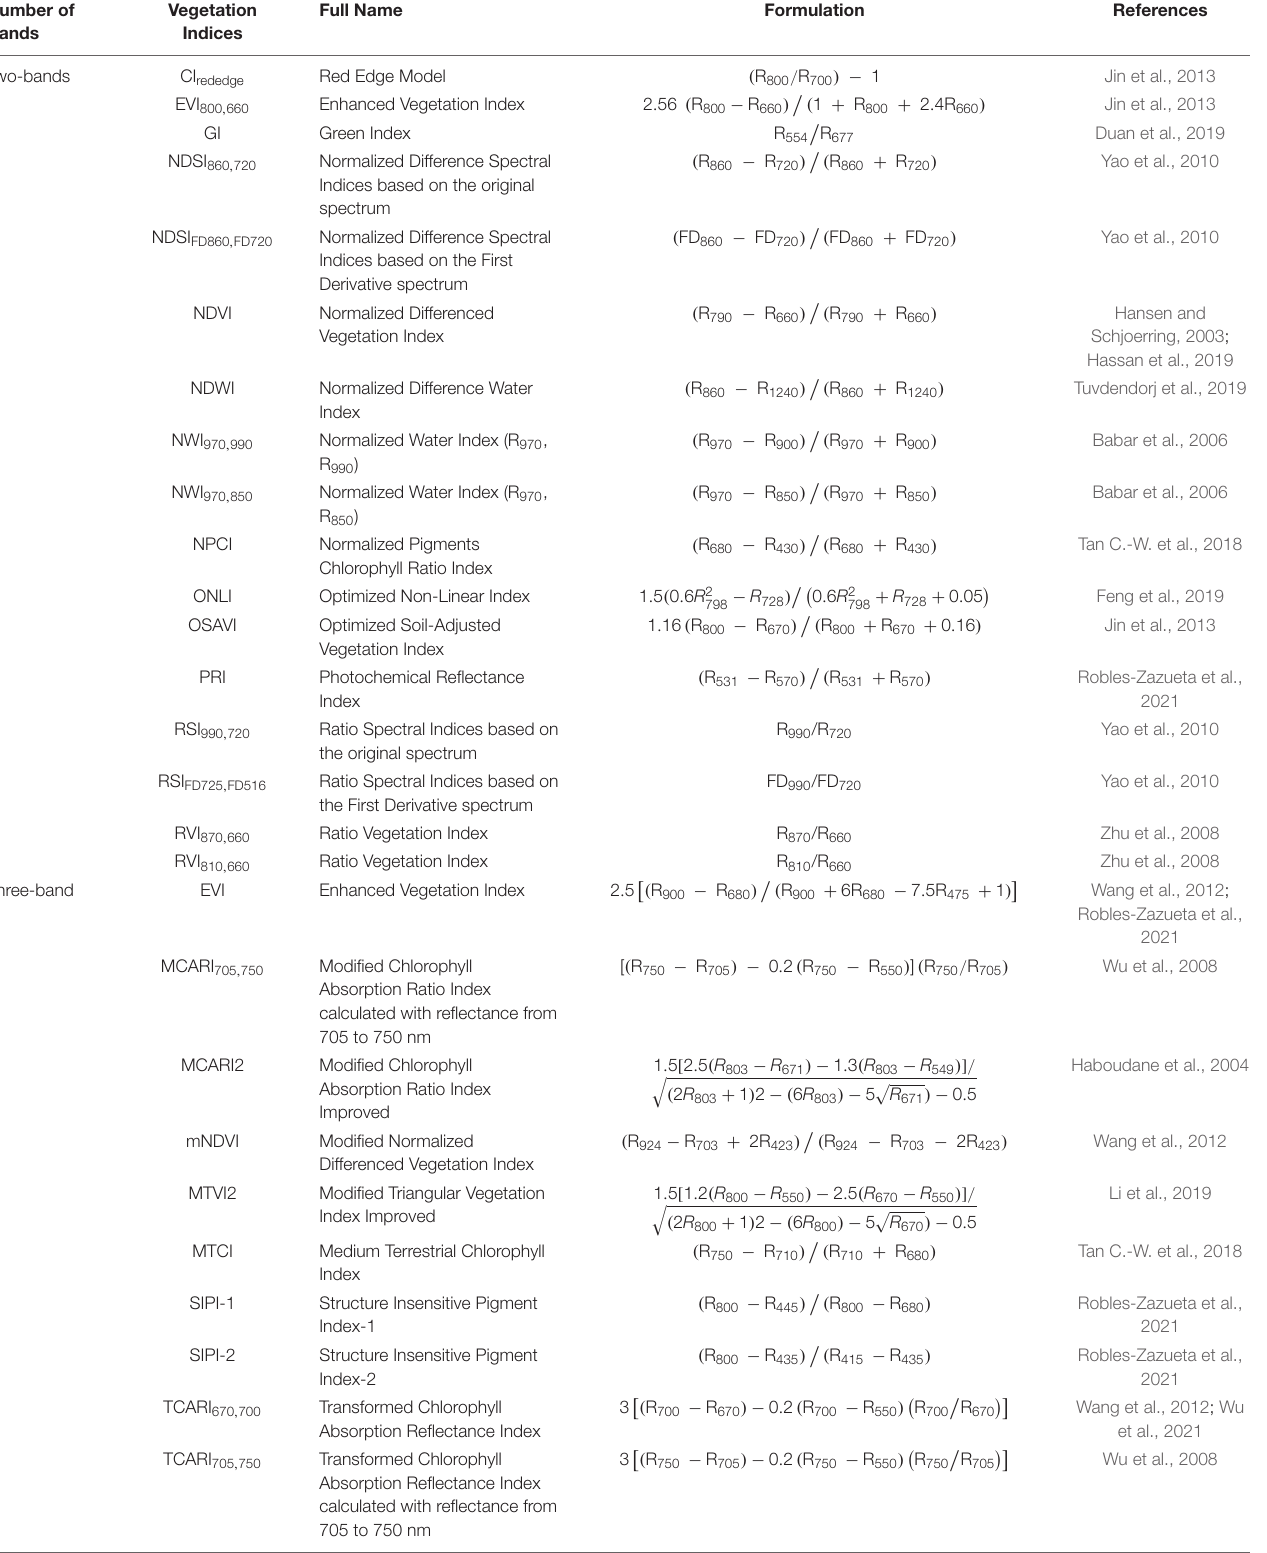
TABLE 1 | The 27 selected vegetation indices (VIs) that have been applied to wheat under field conditions were reviewed in the study, together with their number of spectral bands, band-specific formulations, and associated principal reference, including 17 two-band VIs and 10 three-band VIs. Number of